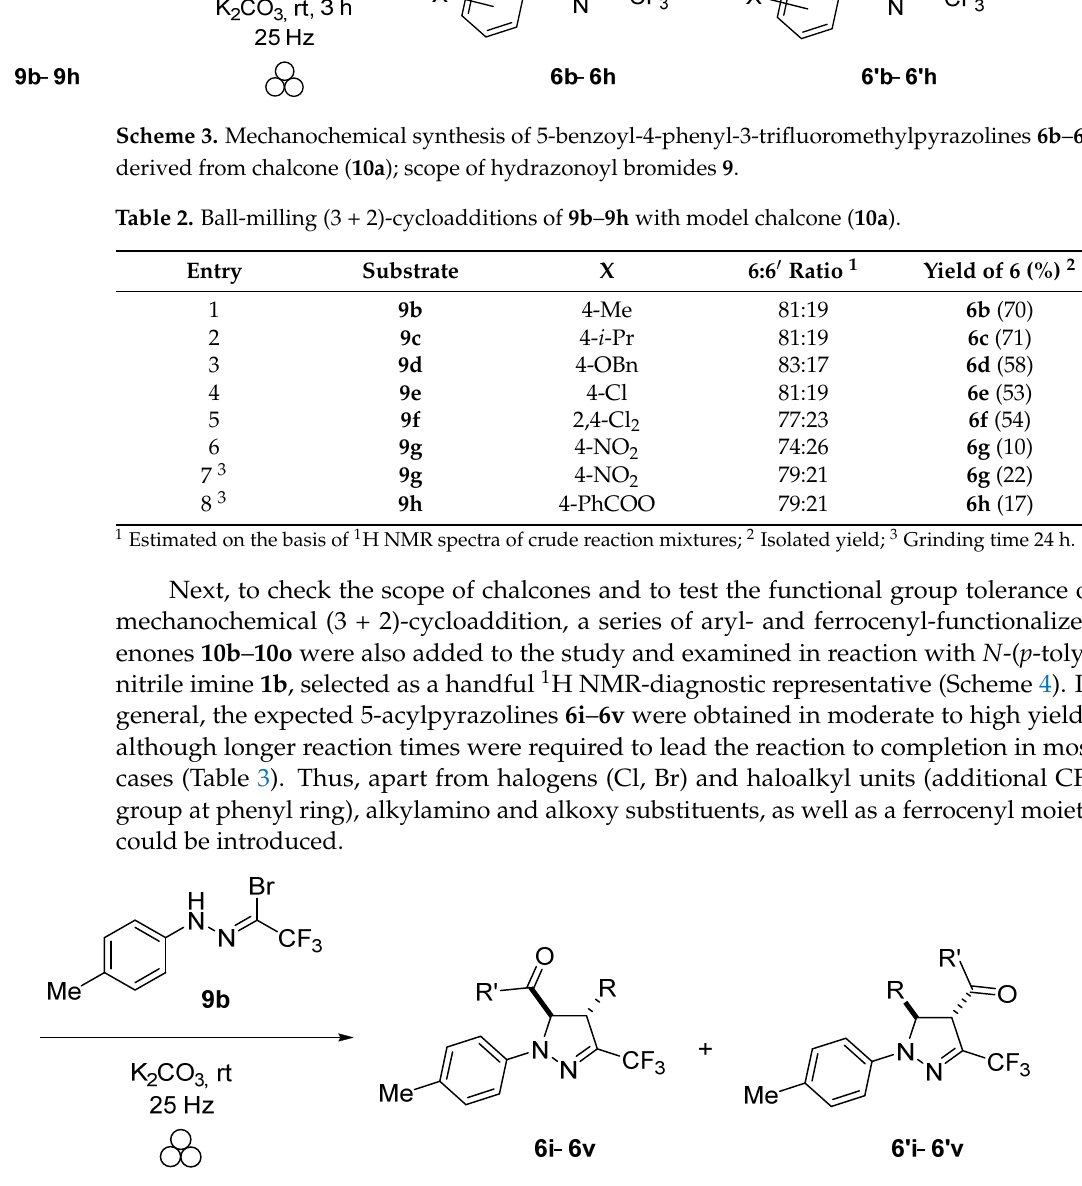
Table 3. Mechanochemical (3 + 2)-cycloadditions of 10b – 10o with model nitrile imine 1b